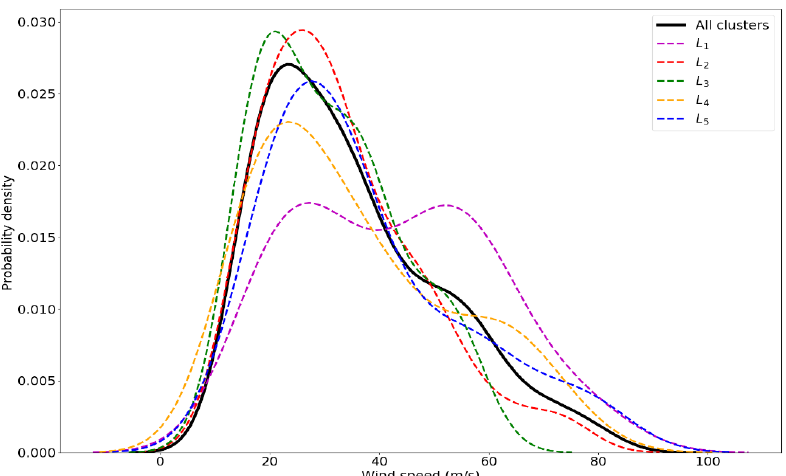
Figure 10. Probability density of intensities at TC landfalling for the wide NATL (the sum of landfalling counts in all regions) and each